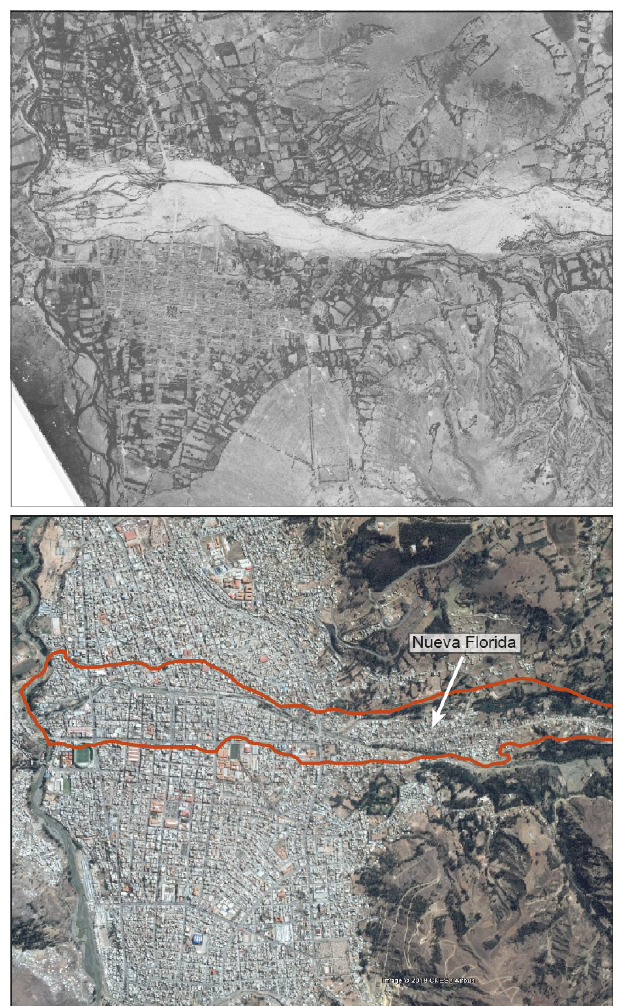
Figure 6. Aerial photograph from 1948 showing the traces of the 1941 GLOF (upper panel) and a 2016 satellite image of the same area (lower panel). The outlines in orange indicate the extent of the area affected by the 1941 GLOF. The highly flood exposed ur- ban district of Nueva Florida is indicated (source of upper image: Archive of Autoridad Nacional de Agua, Peru, year of acquisition: 1948; lower image: © Google Earth/Maxar Technologies, 11 Octo- ber